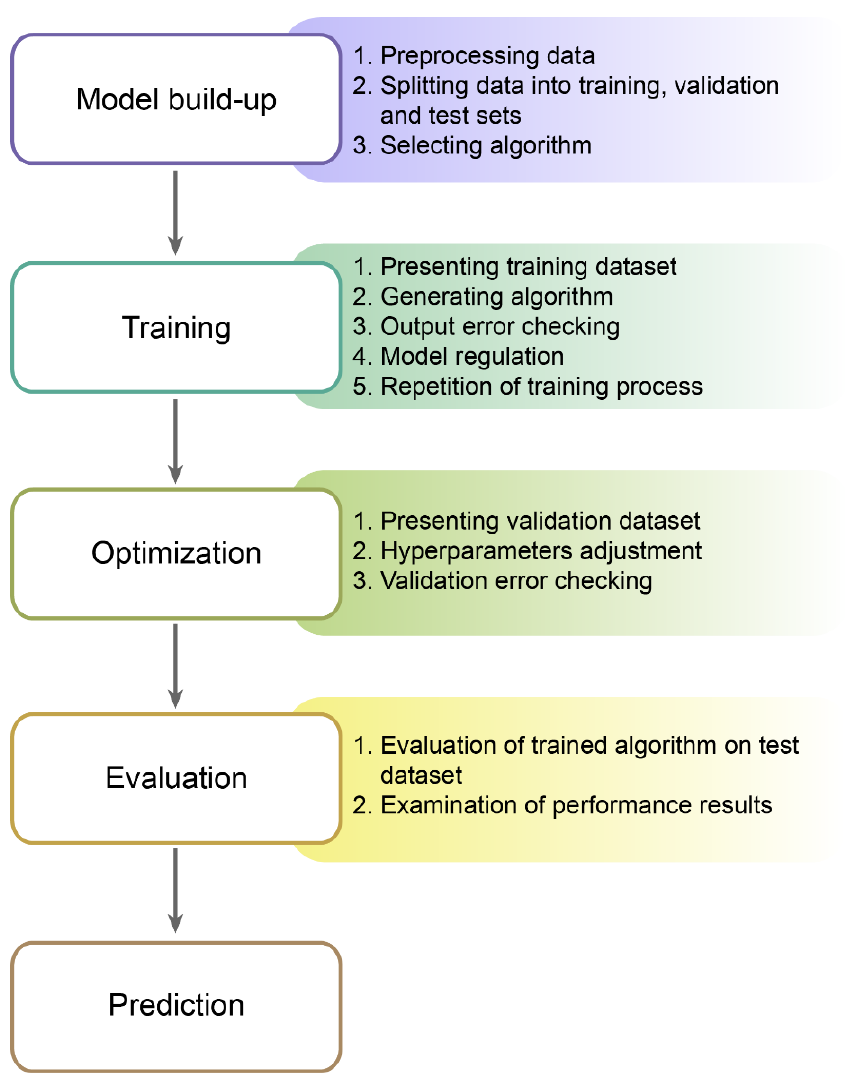
Figure 6. Machine learning process. The machine learning process starts with model build-up. Data need to be preprocessed and split into training, validation, and test sets in this step. The next stage is the training phase, during which parameters are adjusted on the training dataset. Then, during the optimization phase, hyperparameters are tuned on the validation dataset. After the last model adjustments, the trained algorithm processes the final test dataset, and the model performance results are examined.